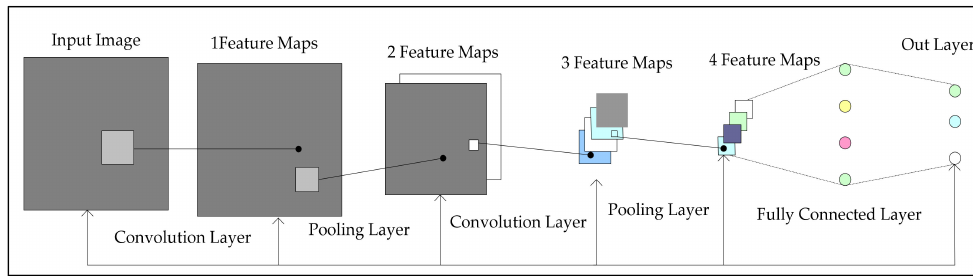
Figure 4. The standard architecture of the